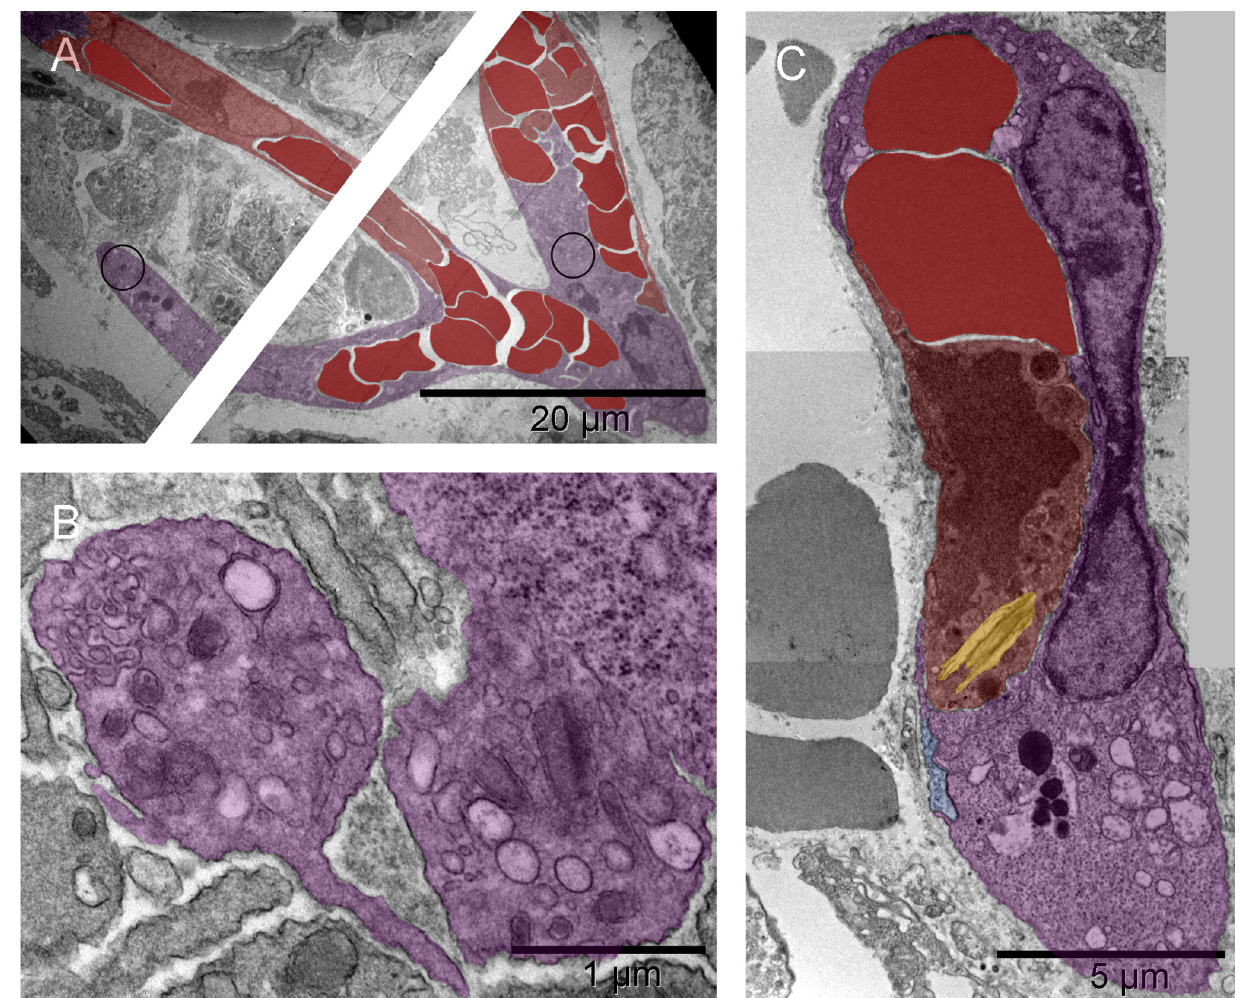
Figure S2. Primitive vascular pattern formed by megakaryocytes without endothelium. Primitive vascular pattern in the tumor-harboring solid tissue below the hyaline membrane consisted of megakaryocytes and platelets (purple) engaged in direct and tight contact with one another and with erythrosomes and erythroblasts (red). There were no ECM-filled spaces left between them nor was there an additional cellular layer covering those elements. The elongated branching structure in [ A ] appeared kept together by megakaryocytes and platelets (N.B. the cutting imperfection mentioned in Figure 2 has been removed here). In the two circled regions of that structure, incomplete separation of platelets from megakaryocytes provided ultrastructural evidence for their identity and for an ongoing process of generating platelets at that location. One region was the bifurcation area at the base of the right almost vertical branch, enlarged in [ B ] and the other was the tip of the lower left branch (enlargement not shown). Evidently, megakaryocytes were capable of organizing erythrosomes into branching primitive vascular structure before ECs emerged to provide protective walls of a vessel. In a smaller elongated structure of similar nature, although without platelets in the section plane, one of the cells contained an Auer body [ C ], previously described in neutrophils from cases of leukemia and defined as azurophilic, large, elongated granules (Figure 64-10 in 57 ). The upper part of that cell contained two erythrosomes; whereas what remained of the nucleus had a different texture compared with that of the nucleus in the second cell of that complex. The prominent dark granules of the latter resembled those in the cell next to the megakaryocyte from the tip of the lower branching structure in [ A ]. If the irregularly shaped seemingly empty space next to those granules was a prototype of a lumen then both those cells could have potentially been